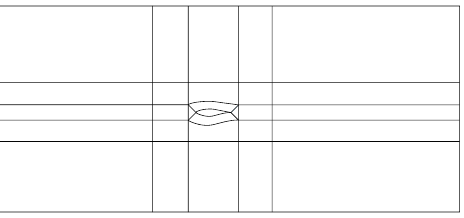
Figure 12. Blocking structure for the fluid